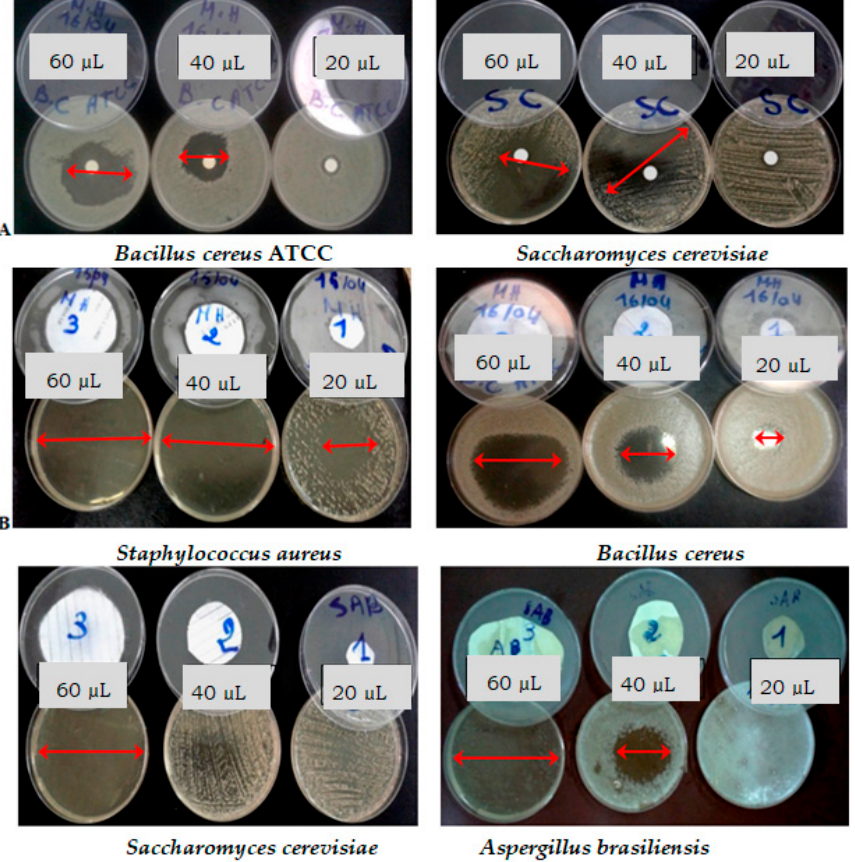
Figure 1. In vitro inhibitory activity of Eucalyptus globulus essential oil against bacterial and fungal species: Disc diffusion ( A ) versus vapor diffusion ( B ) methods using three different quantities of EO (20, 40 and 60 µL/disc). Red arrows are the diameter of the inhibitory zone (DIZ).